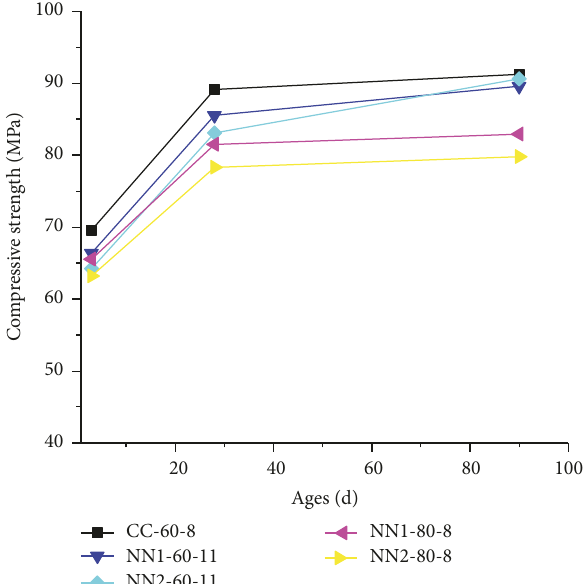
Figure 21: Compressive strength of the steam-cured concrete with W/B of 0.32.